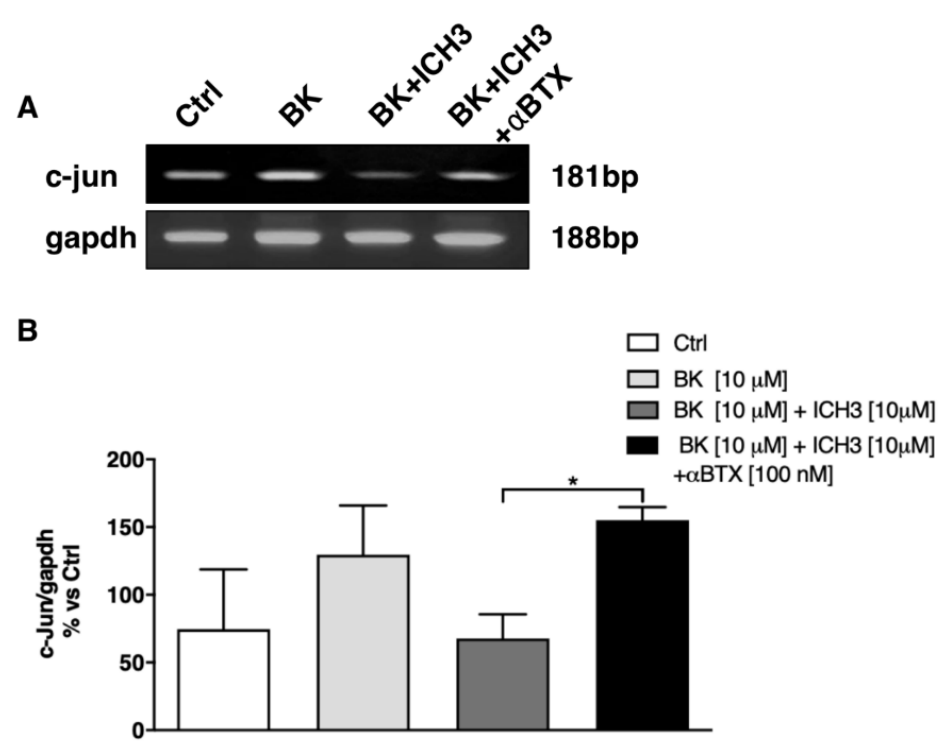
Figure 3. c-Jun transcript level expression in cultured sciatic nerve after BK and ICH3 treatment. Sciatic nerves were placed in media containing the inflammatory agent BK for 24 h followed by an additional 24 h in the presence of the α 7 agonist ICH3 in the absence or presence of α 7 antagonist α BTX. ( A ) RT-PCR analysis of c-Jun expression; GAPDH was used as the housekeeping gene. ( B ) Graph shows the densitometric analysis of the bands obtained from three independent experiments, normalized against the housekeeping gene. (n = 3; * p < 0.05).